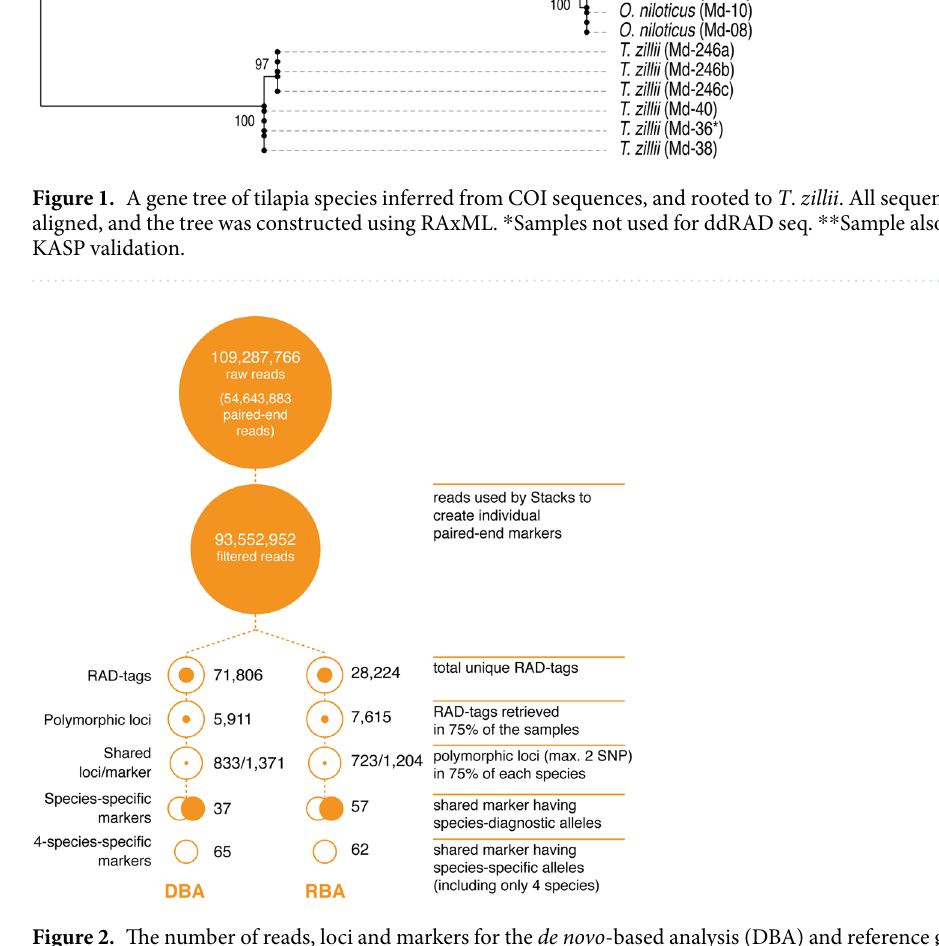
Figure 2. The number of reads, loci and markers for the de novo -based analysis (DBA) and reference genome- based analysis